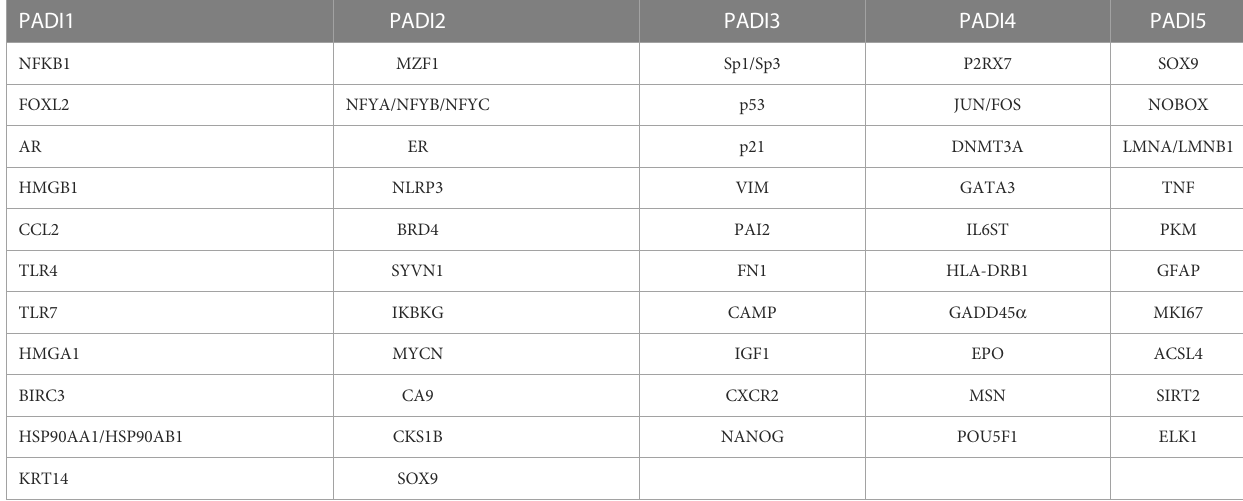
TABLE 4 Genes involved in this